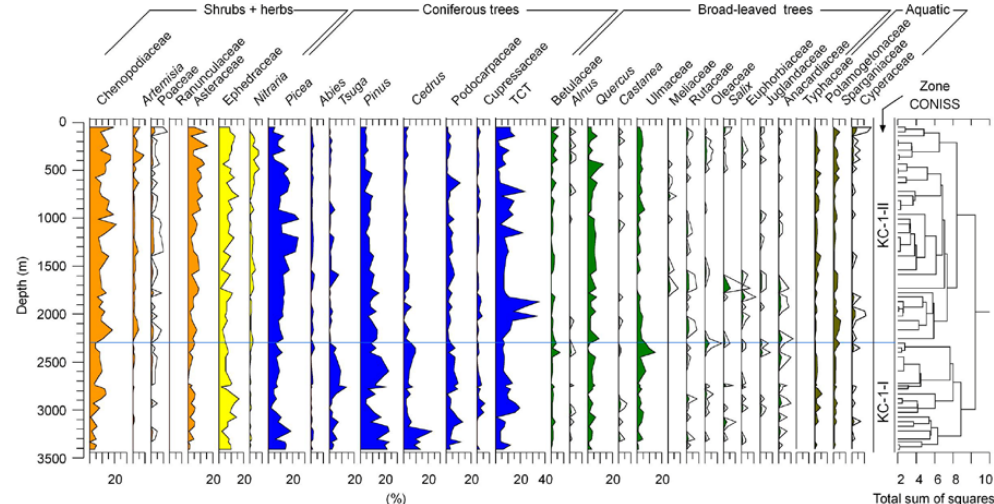
Fig. 3. KC-1 core pollen diagram in the western Qaidam Basin adapted from Miao et al. (2011) (TCT: Taxodiaceae/Cupressaceae/Taxaceae).